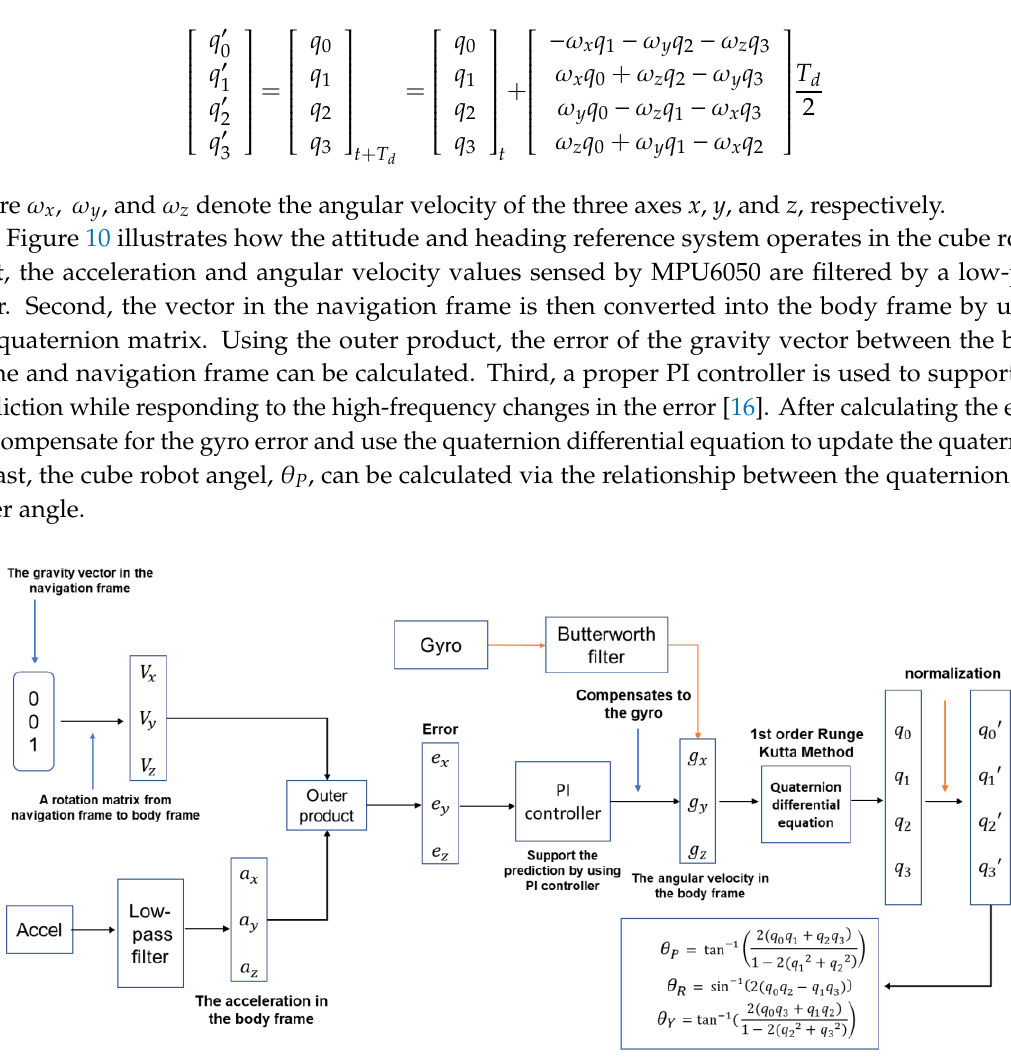
Figure 10. The schematic diagram of the attitude and heading reference system (AHRS).